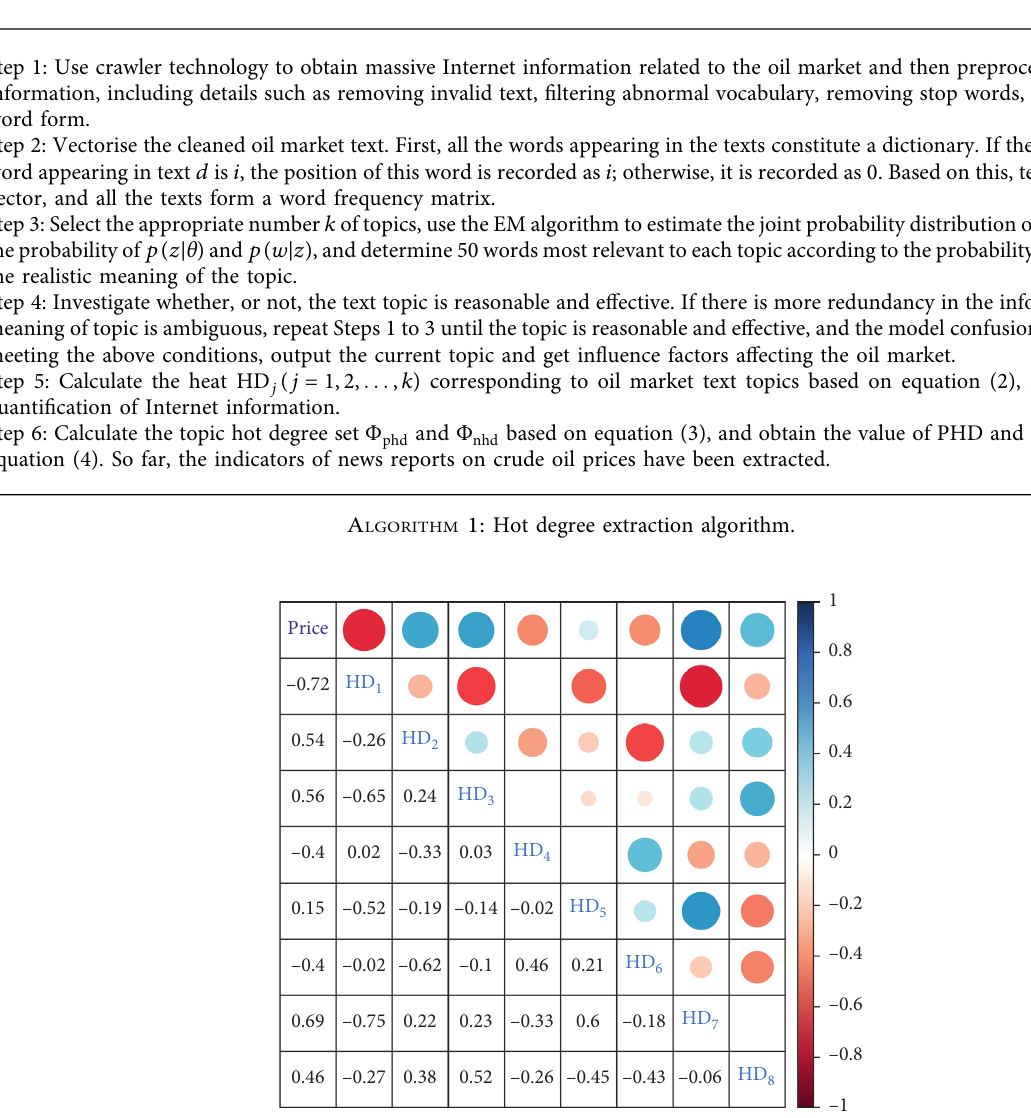
j ” represents the hot degree of